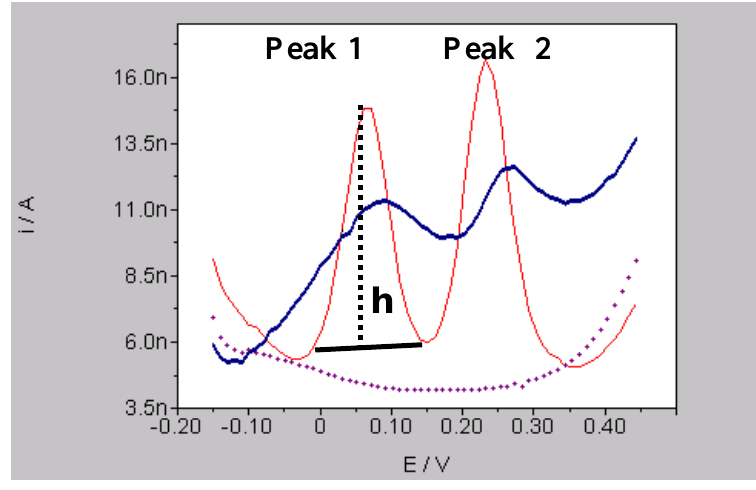
Figure 2. In vitro and in vivo differential pulse voltammograms obtained with mCFE. Dotted line shows signals obtained in phosphate buffer solution (PBS, pH 7.4), red line shows signal for DA (Peak 1) and 5-HT (Peak 2) obtained in PBS containing at 100 nM and blue line represents in vivo signals obtained in the NAc of anaesthetised rats.; h : height of the peak, measured in nanoAmperes ( I/A : Intensity of current). This perpendicular line also determined the exact potential value ( E : espressed in Volts) of each signal on the